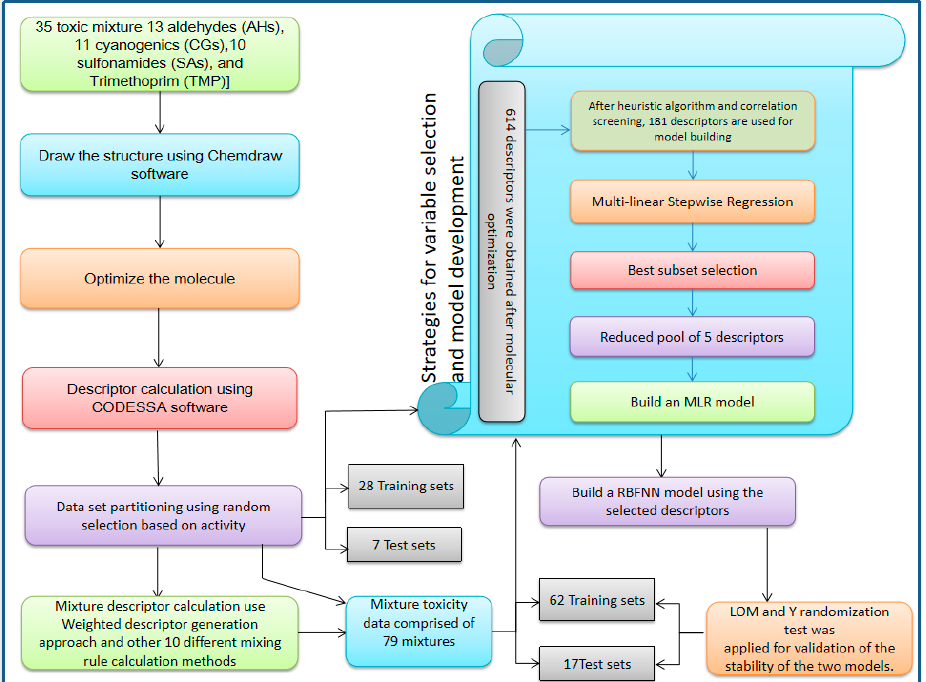
Figure 1. Schematic diagram of the entire approach involved in the development of the QSAR models.